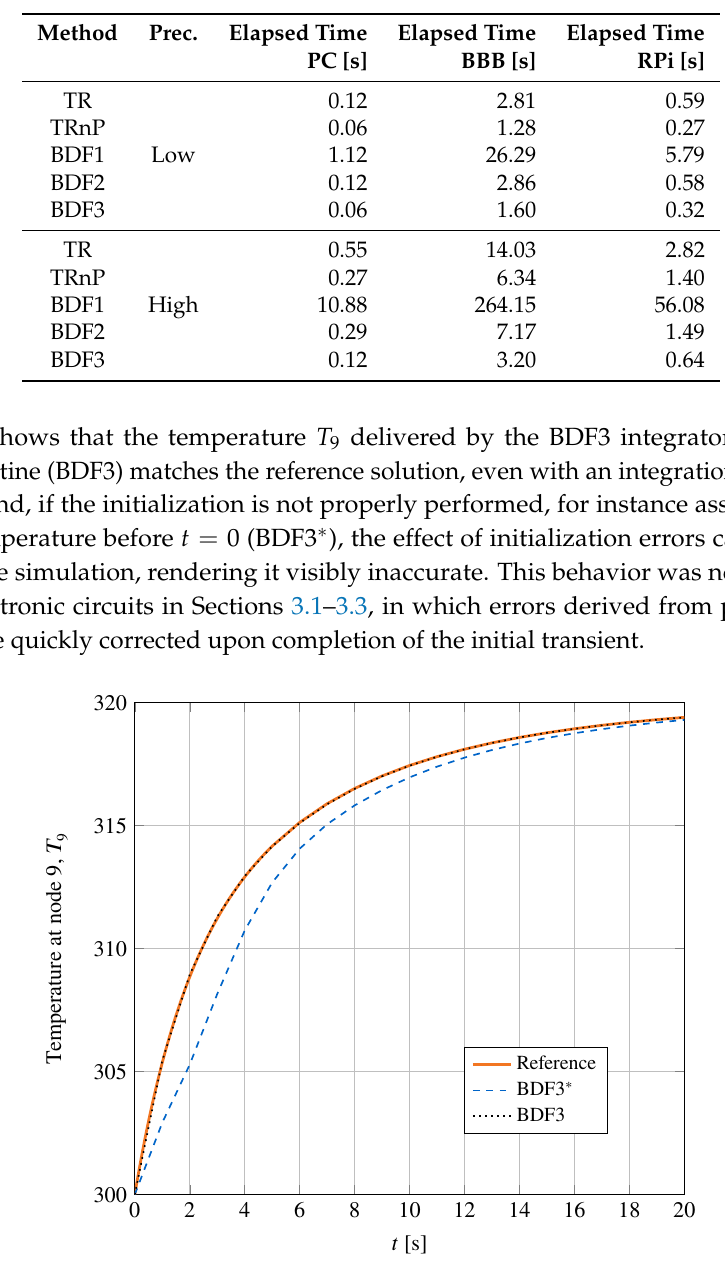
Table 19. Elapsed times in the simulation of the thermal circuit of the synchronous motor.